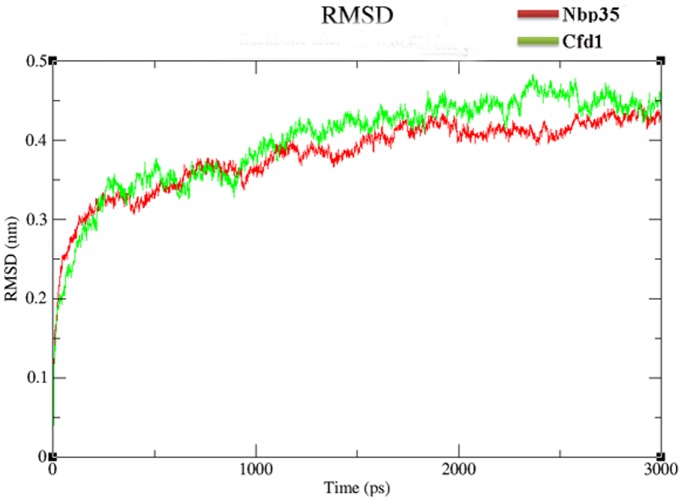
RMSDs time scan for Nbp35 and Cfd1.Backbone RMSDs are shown as a function of time for Nbp35 (red) and Cfd1 (green) protein at 3 ns.